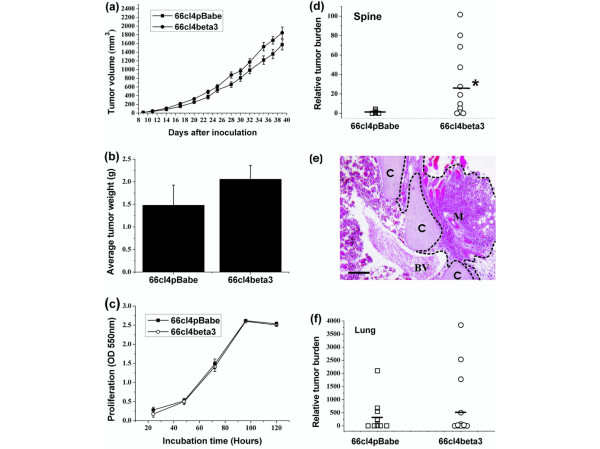
Tumor expression of αvβ3 integrin promotes spontaneous metastasis to the spine but not primary tumor growth. Cells (1 × 104 in 20 μl of 50% Matrigel) were inoculated into the mammary gland of Balb/c mice (15 mice per group). (a) Primary tumor volumes were measured three times per week. (b) Primary tumor weights were recorded on the day of harvest (day 39). (c) In vitro proliferation of 66cl4pBabe and 66cl4beta3 cells. The tumor burden in the (d) spine and (f) lungs was measured by real-time quantitative PCR as described in Materials and methods. Each point represents one mouse, but not all points are distinguishable. The average metastatic burden for each group is shown with a line. *P = 0.01. (e) H&E of a 66cl4beta3 spontaneous femoral metastasis. A metastatic nodule (M) in proximity of a blood vessel (BV) is seen invading through the cortical bone (C). Scale bar = 100 μm.